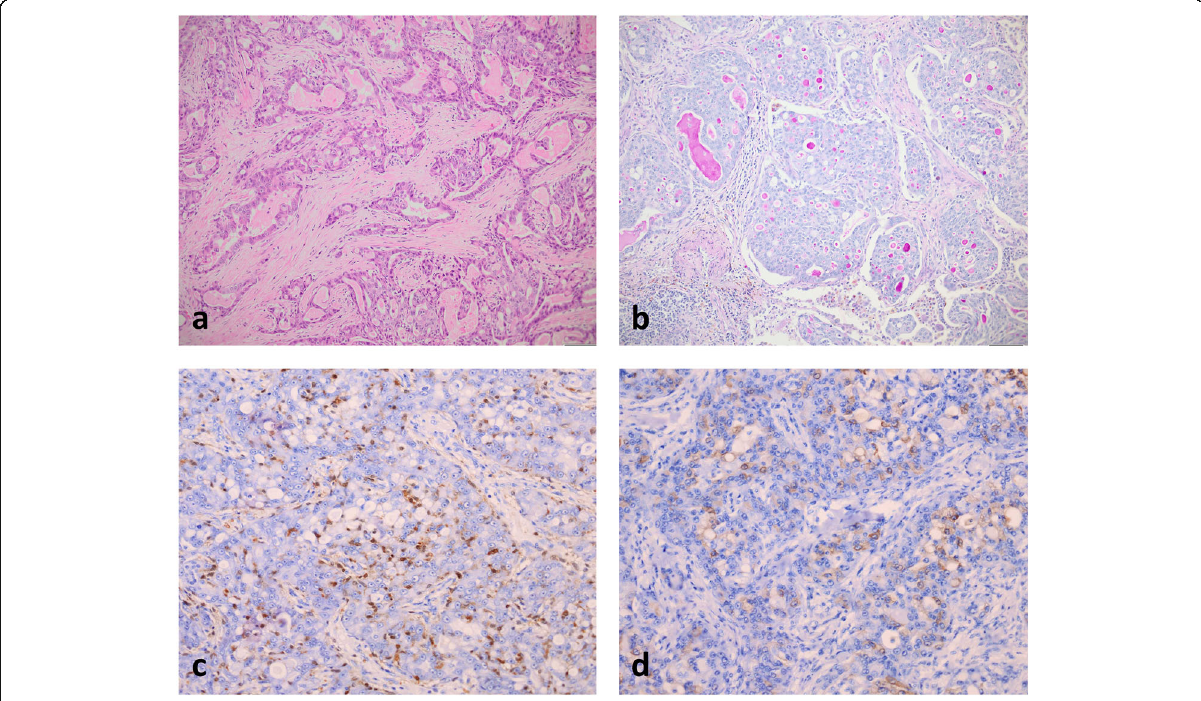
Fig. 1 Histological and immunohistochemical features of the tumour. a Infiltrates of secretory carcinoma show microcystic to reticular and focally tubular growth and moderate nuclear pleomorphy with accompanying desmoplastic stromal reaction (HE staining). b Focal intra- and extracellular PAS-positive mucin production is recognized (PAS staining). c Focal expression of S100 protein. d Mammaglobin expression in part of tumour